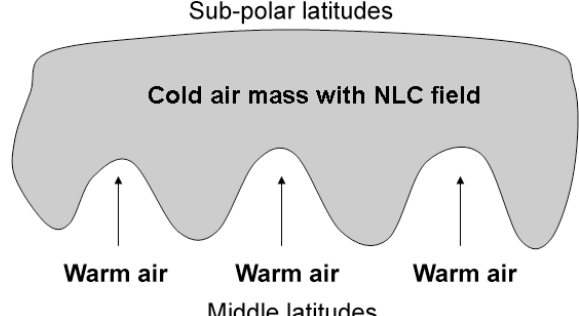
Figure 6. A schematic representation of the intrusion of warm air masses from mid- to sub-polar latitudes, forming partial ice voids in the observed NLCs. A general concept of this scheme is analogous to the formation of a wave cyclone in the troposphere (see Figs. 8.18 and 8.19 in Ahrens,